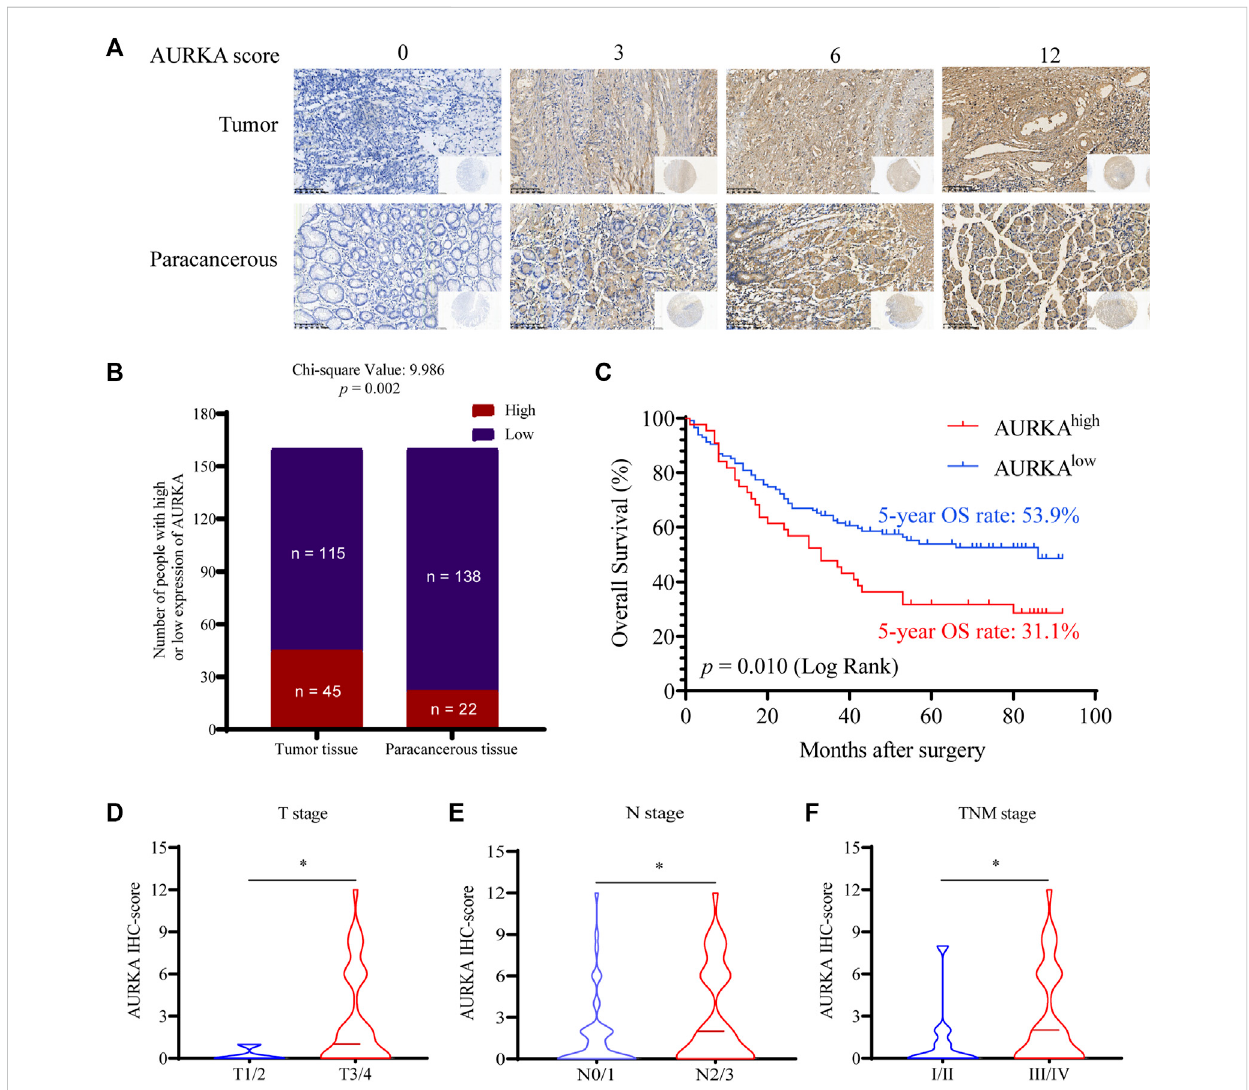
FIGURE 1 AURKA is highly expressed in GC tissues and is associated with poor prognosis in GC. (A) Representative images of IHC staining of AURKA with different H-scores in 160 GC patient tissue microarray constructions (400×). (B) Differential expression of AURKA in GC tissue and matched adjacent tissues ( p = 0.002). (C) The survival curves of GC patients with different AURKA expression levels ( p = 0.01). (D) The AURKA IHC score in GC patients with different T stages, * p < 0.05. (E) The AURKA IHC score in GC patients with different T stages, * p < 0.05. (F) The AURKA IHC score in GC patients with different T stages, * p <